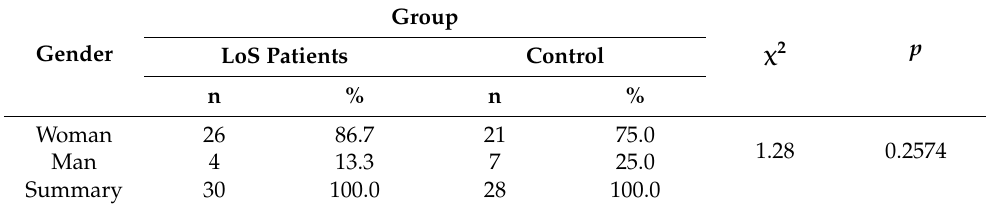
Table 1. Gender structure of LoS patients and HCs.